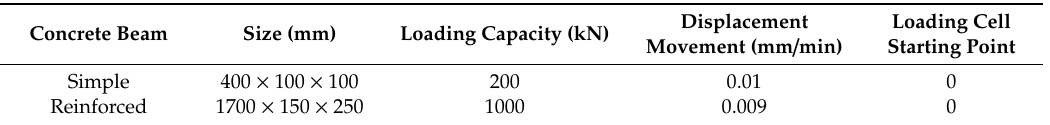
Table 1. Specifications for experimental setup.